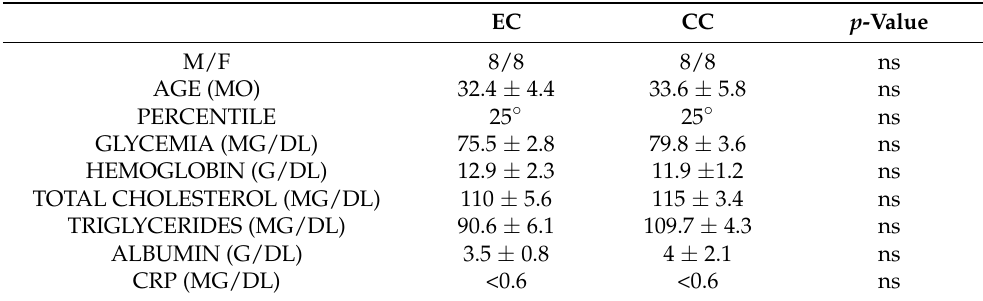
Table 1. Main anthropometric and biochemical characteristics of children with generalized epilepsy (EC) and control children (CC) recruited for the study. EC CC p -Value M/F